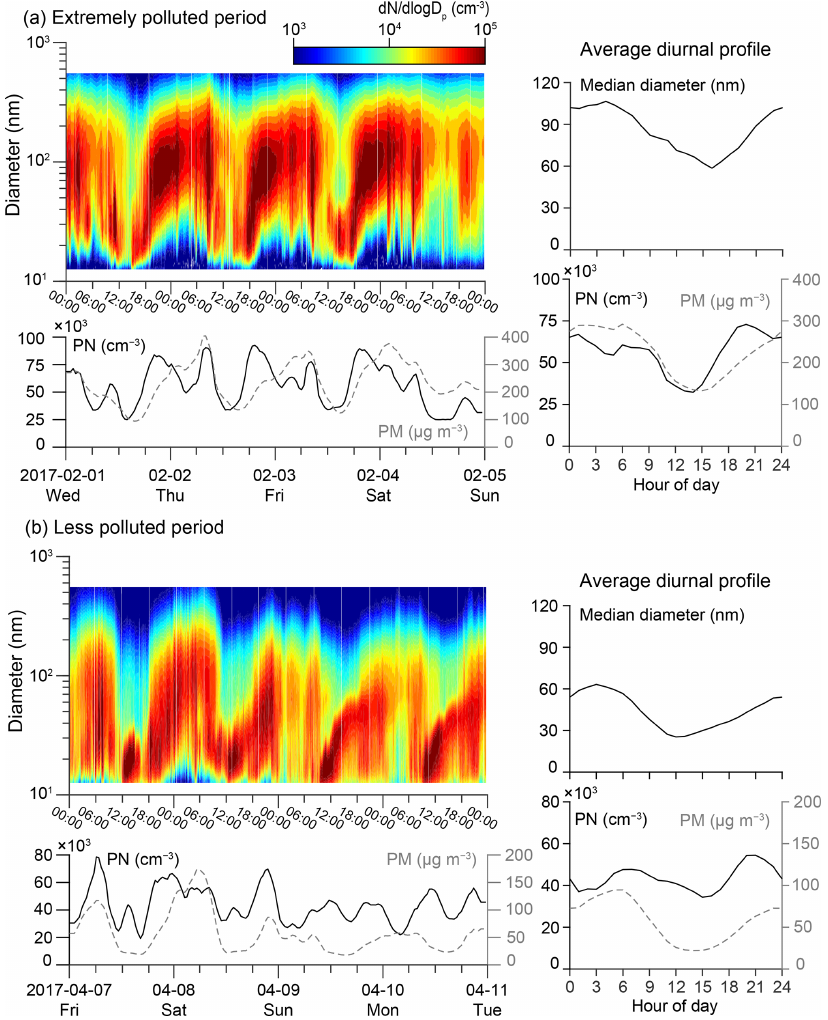
Figure 7. Heat map showing the evolution of the PSDs for a (a) polluted period with prominent coagulation scavenging and (b) less polluted period with some new particle formation and growth. Bulk PN and PM concentrations for the same period as the heat map are also presented for both periods. The average diurnal profile of the median diameter, along with the PN and PM concentrations over the two periods, is presented in the right panels. Estimation of PM concentrations were based on the volume concentrations observed by the SMPS and assuming the particle density to be 1.6gcm − 3 .